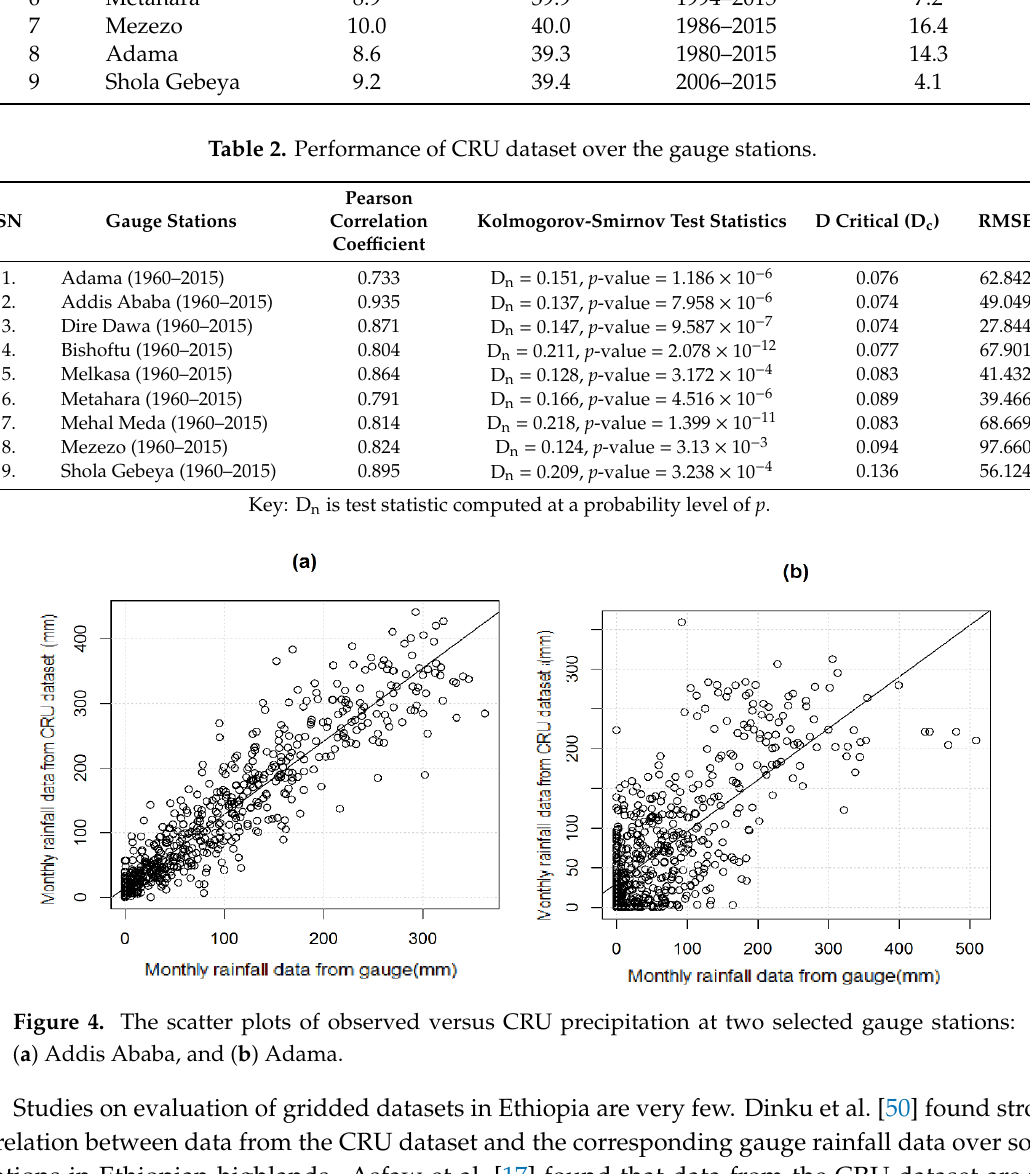
Table 2. Performance of CRU dataset over the gauge stations.